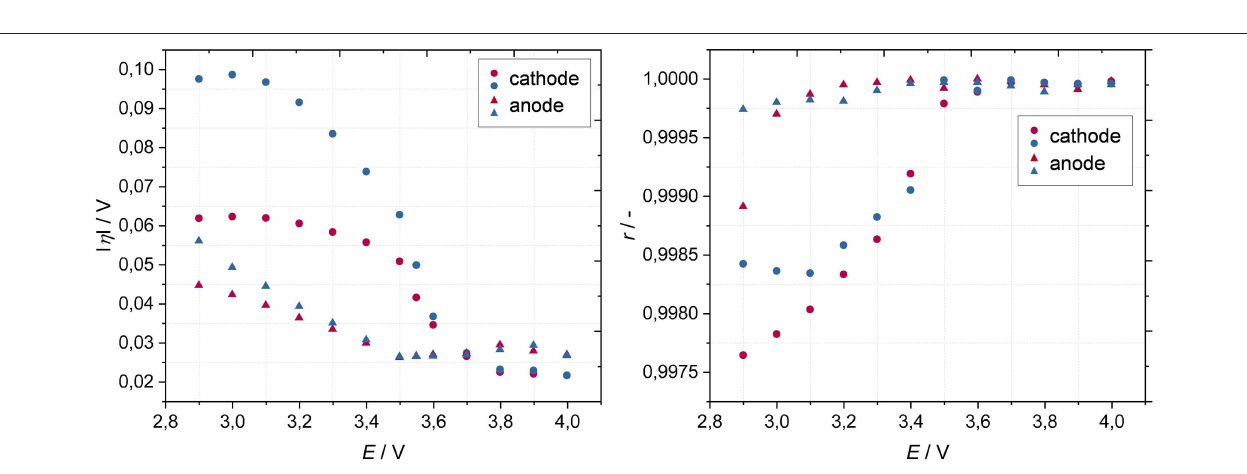
FIGURE 5 | Overpotentials based on a DC bias of 5mA (Left) and corresponding correlation coefficients based on a DC bias range of 1–5mA ( 1 I = 1mA) (Right) of cathode and anode in charge (red) and discharge (blue) direction as a function of cell voltage at a temperature of 20 ◦